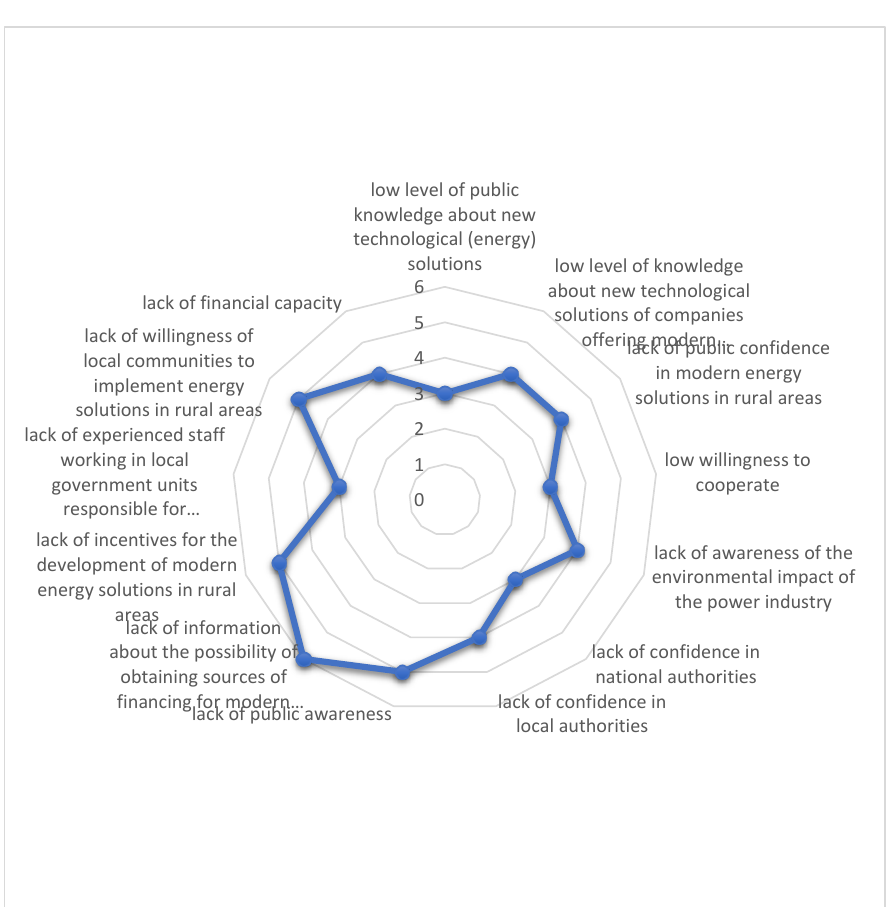
Figure 3. Relevance of challenges in energy development in rural areas as assessed by farmers. Source: own elaboration.